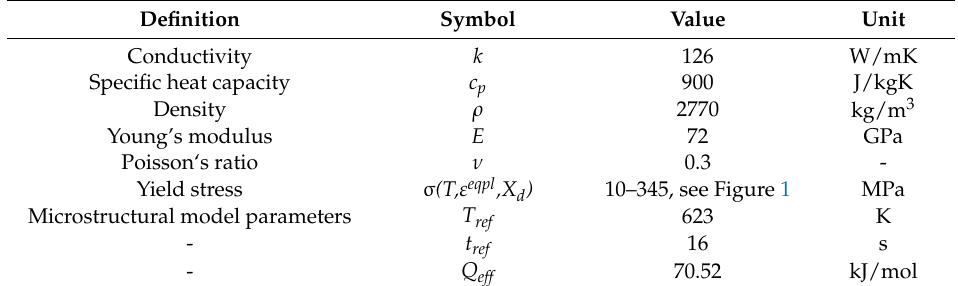
Table 3. Material properties used for the AA2024-T3 material in the thermomechanical